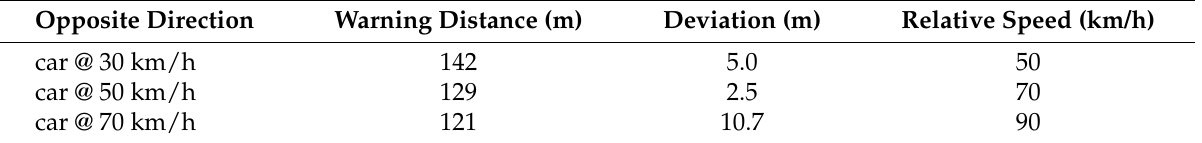
Table 2. Distance at which the alarm is displayed when the vehicles moves in the opposite directions. Opposite